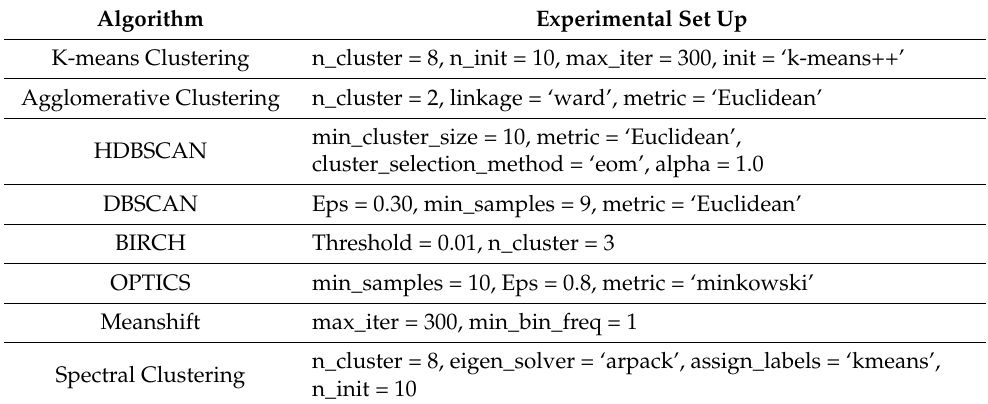
Table 2. Clustering algorithms.